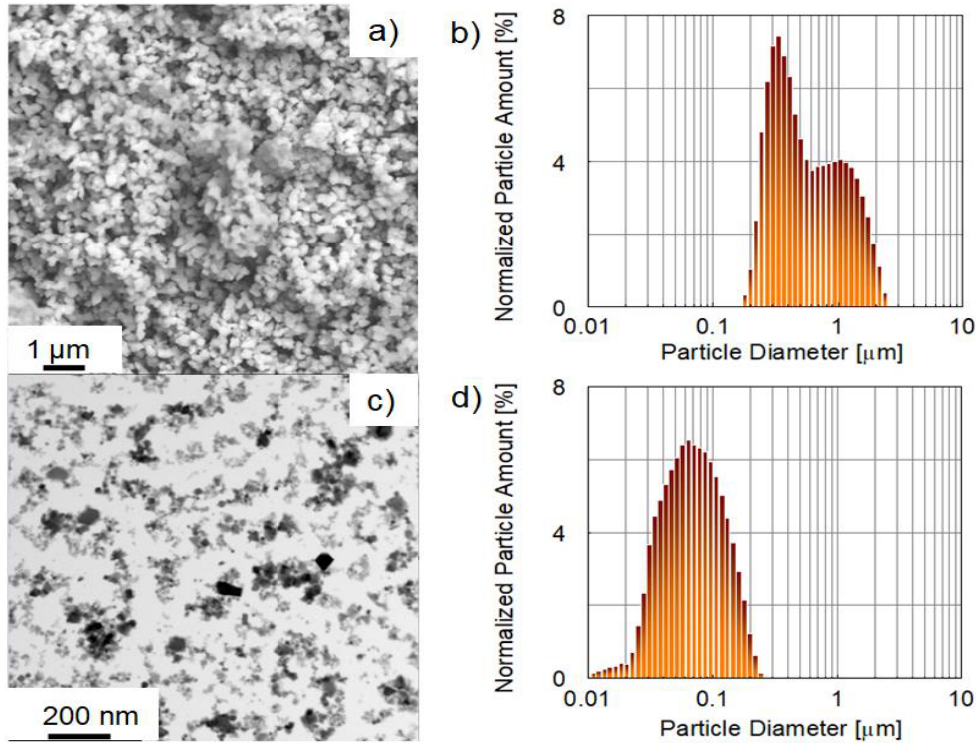
Figure 1. SEM ( a ), scanning transmission electron microscopy (STEM) ( c ) images, and particle size distributions ( b , d ) of MgAl 2 O 4 and CeO 2 nanopowders.